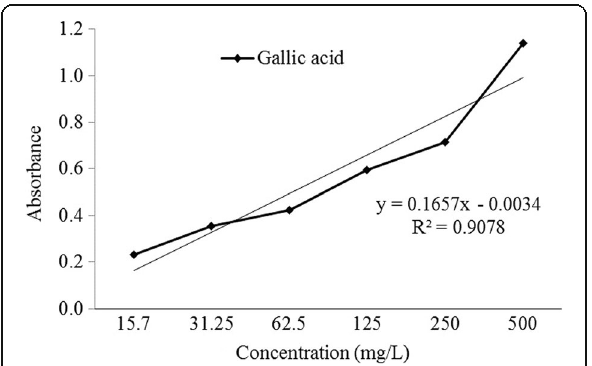
Fig. 3 Quercetin standard calibration curve for the determination of total flavonoid